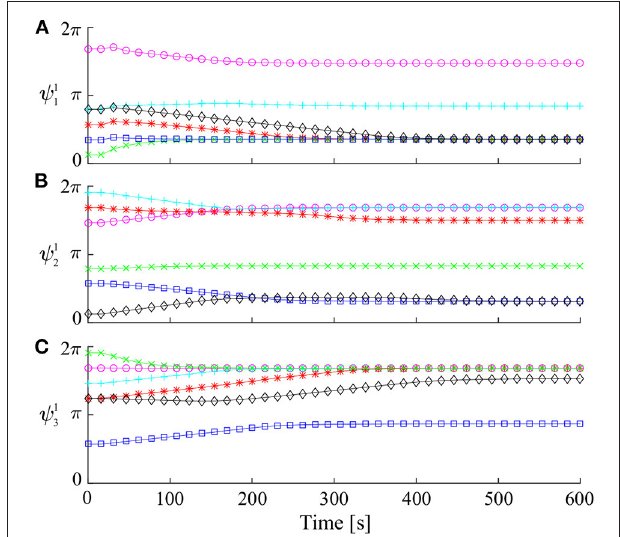
FIGURE 3 | Time profile of relative phases for 9 1 simulated from six sets of initial values: (A) ψ 1 1 , (B) ψ 1 2 , and (C) ψ 1 3